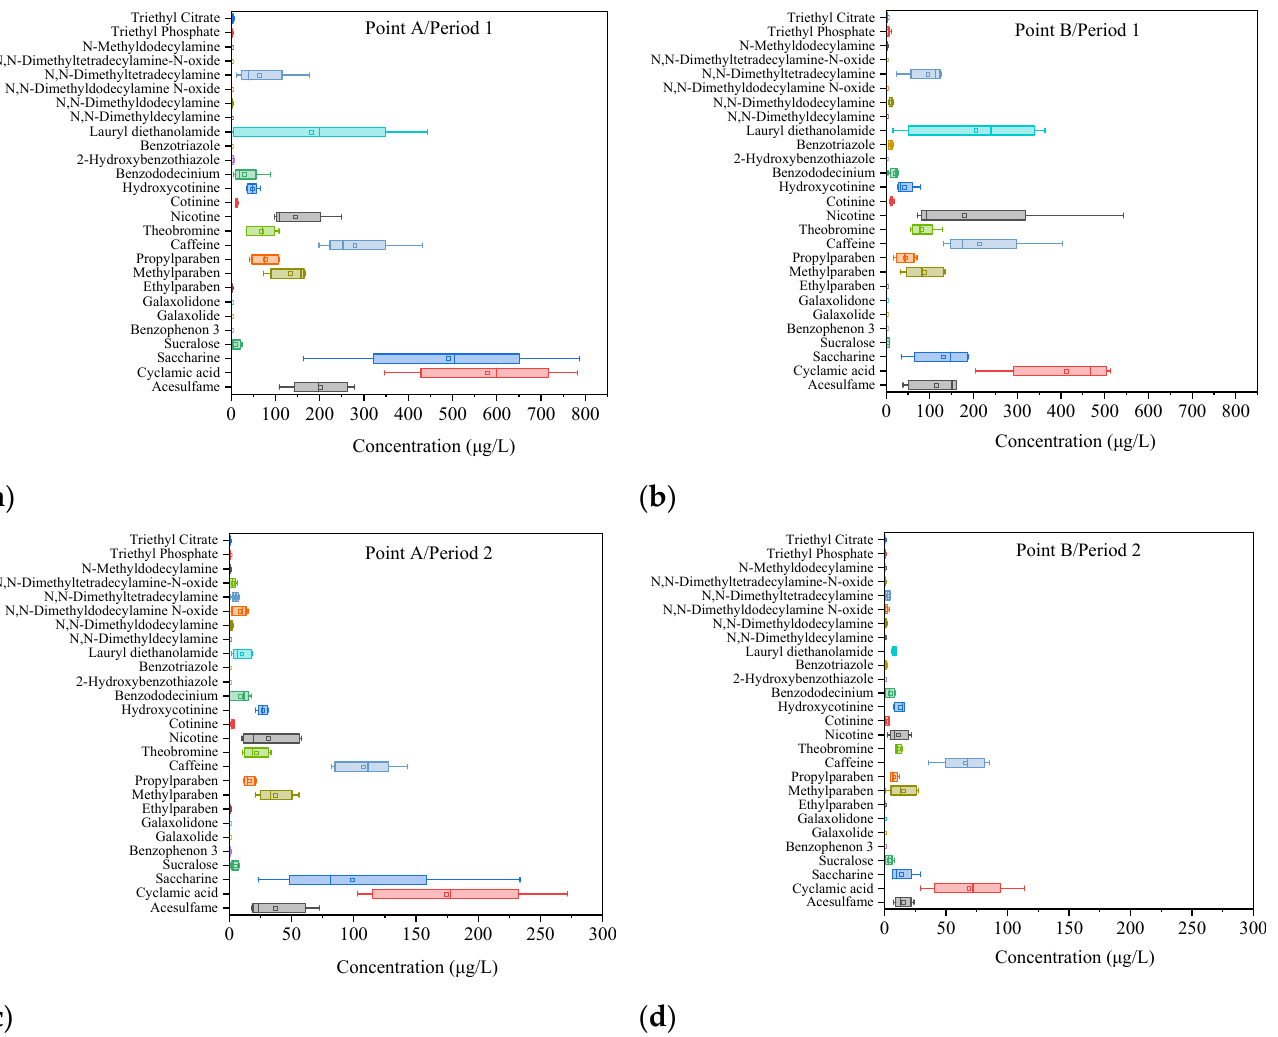
Figure 3. Box-whisker plots of the average measured concentrations for each sampling site and period. Data for Point A/Period 1 ( a ), Point B/Period 1 ( b ), Point A/Period 2 ( c ), and Point B/Period 2 ( d ) are shown. Boxes represent lower (25%) and upper quartiles (75%). The line inside the box represents the median, while square points inside the box represent the mean values, and whiskers represent 1.5× interquartile range.